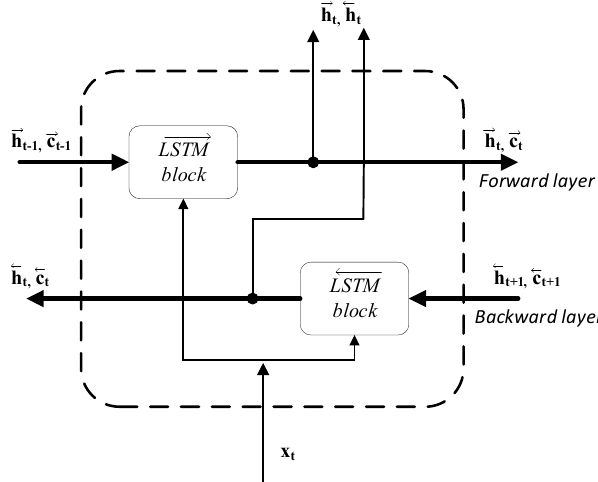
Figure 5. Bidirectional long short-term memory (BiLSTM) flow of data at time step t.